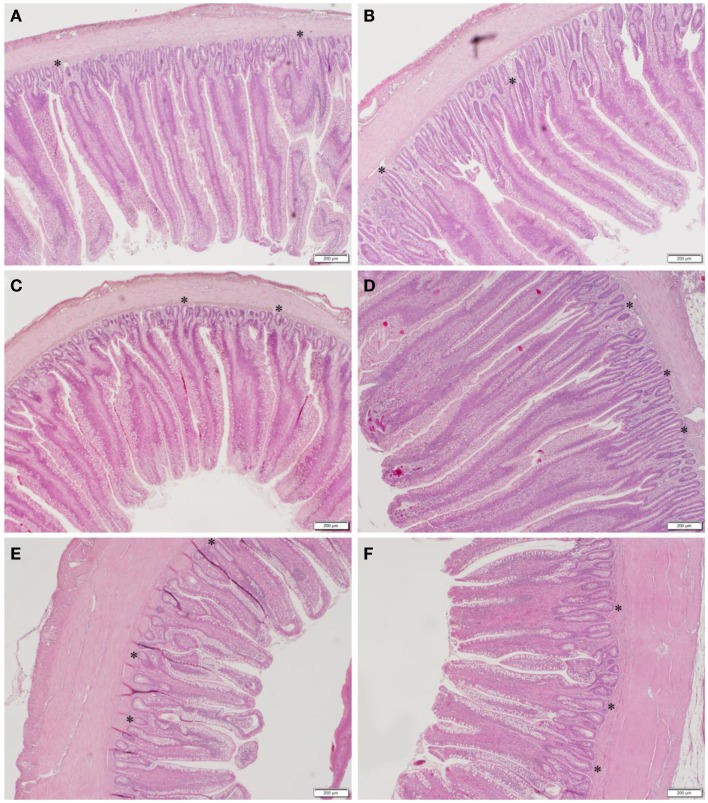
Representative images of duodenum (A,B), jejunum (C,D), and ileum (E,F) in control (A,C,E) and gut barrier failure (B,D,F) groups of broilers chickens at 28 days of age. The representative crypts are shown as *.